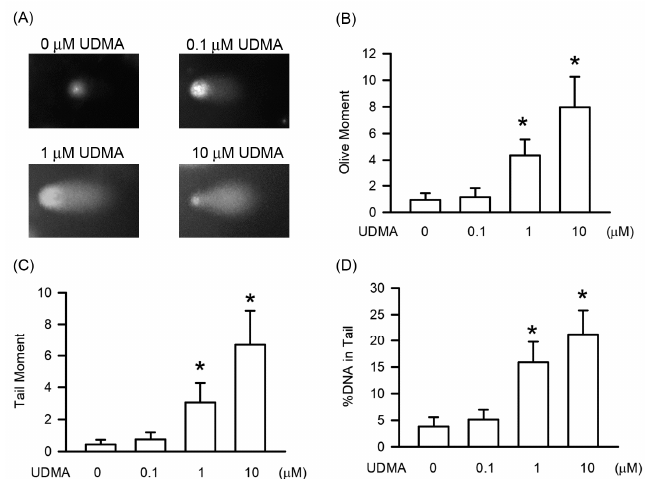
Figure 4. UDMA ‐ induced DNA damage measured using the comet assay in RAW264.7 macrophages. ( A ) Gel electrophoresis of UDMA ‐ treated RAW264.7 cells at concentrations of 0, 1, 10, 100 μ M. ( B ) and ( C ) are quantifications of tail moment and %DNA in tail, respectively. Results are expressed as mean ± SD. *P < 0.05 is considered significant compared with the control group.